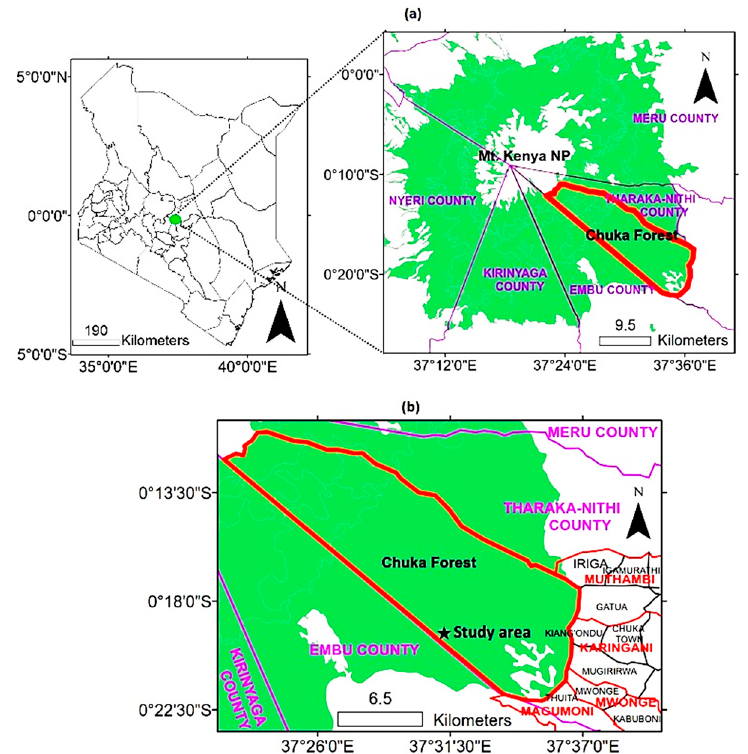
Figure 1. Map of the study area in Mt. Kenya Forest Reserve (MKFR) showing the location of ( a ) Chuka Forest, and ( b ) Chuka Forest and the adjacent locations.